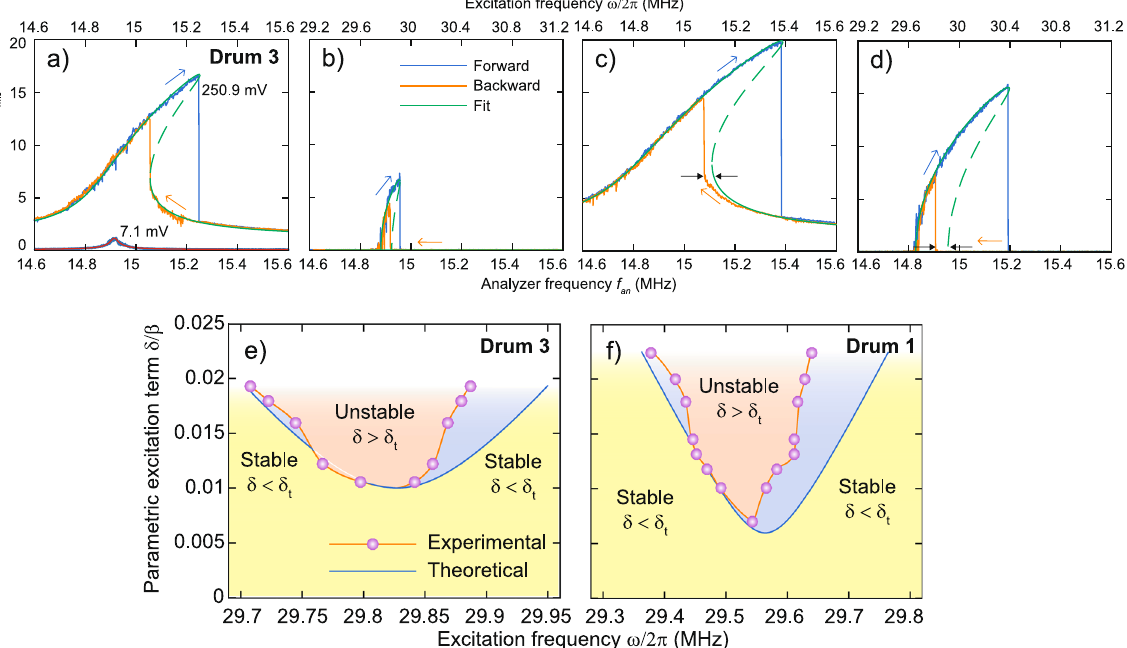
Figure 4. Comparison of experimental mechanical responses to theory. ( a ) Directly driven response at 7.1 and 250.9 mV RMS driving voltage and the fit obtained from Eq. 1. ( b ) Parametric response and fit at 250.9 mV RMS driving voltage and the fit from Eq. 1. ( c ) Directly driven response at 446.2 mV RMS driving level, the fit from Eq. 1 shows a disagreement with the backward sweep, highlighted by black arrows. ( d ) Parametric response at 446.2 mV (RMS). Black arrows highlight the disagreement between Eq. 1 and experiment. ( e ) Parametric resonance instability map for the fundamental mode of drum 2, compared to the prediction from Eq. 1. ( f ) Parametric resonance instability map for the fundamental mode of drum 1 (Fig.